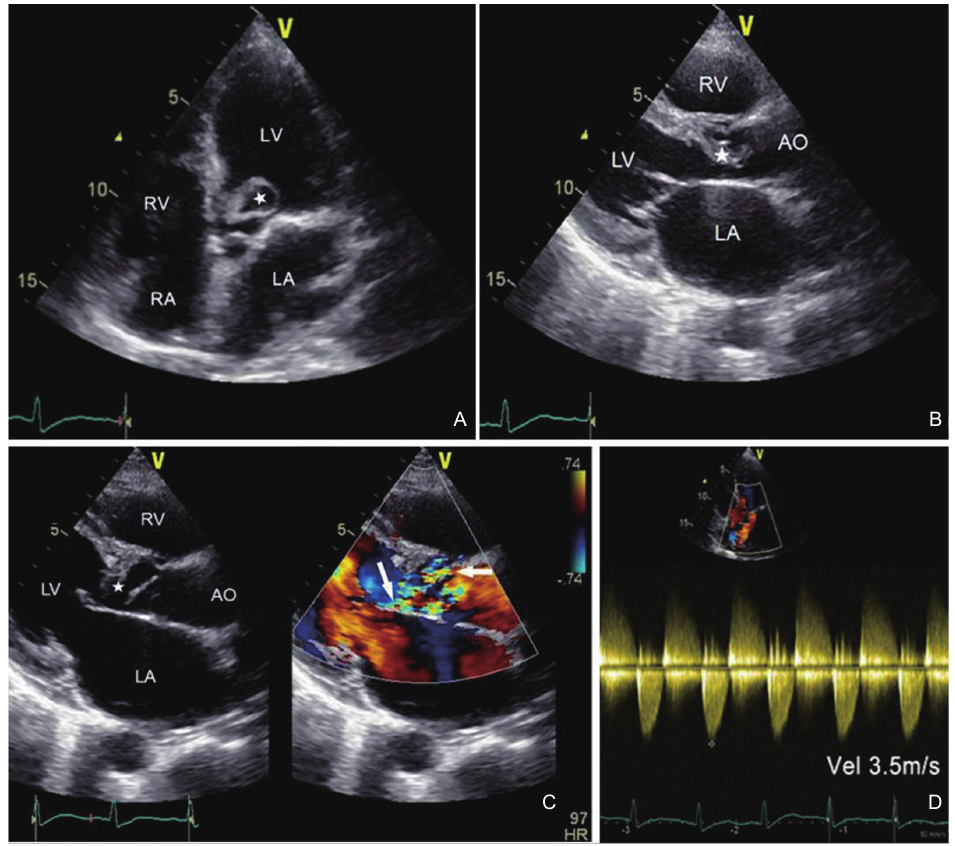
Figure 1 Transthoracic echocardiography images. TTE showed that the sac (pentagram) expanded to the left ventricular outflow tract during diastole (A) and collapsed back to aorta during systole (B). TTE showed the discontinuity of the sac wall (pentagram). Color Doppler flow imaging showed a large shunt flow from the sac to left ventricular outflow tract (C). Continuous-wave Doppler showed a peak velocity of 3.5m/s at aortic root (D). AO, aorta; AV, aortic valve; LA, left atrium; LV, left ventricle; RA, right atrium RV, right ventricle.